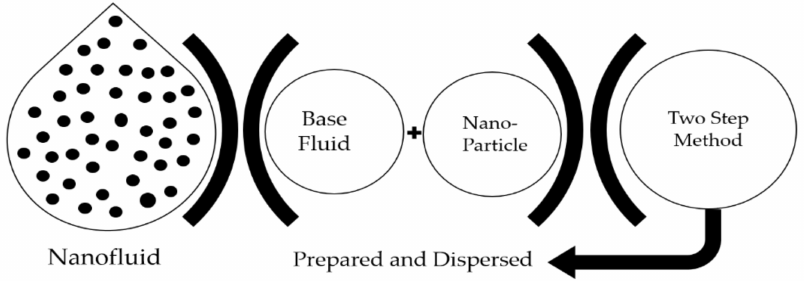
Figure 7. Two-step